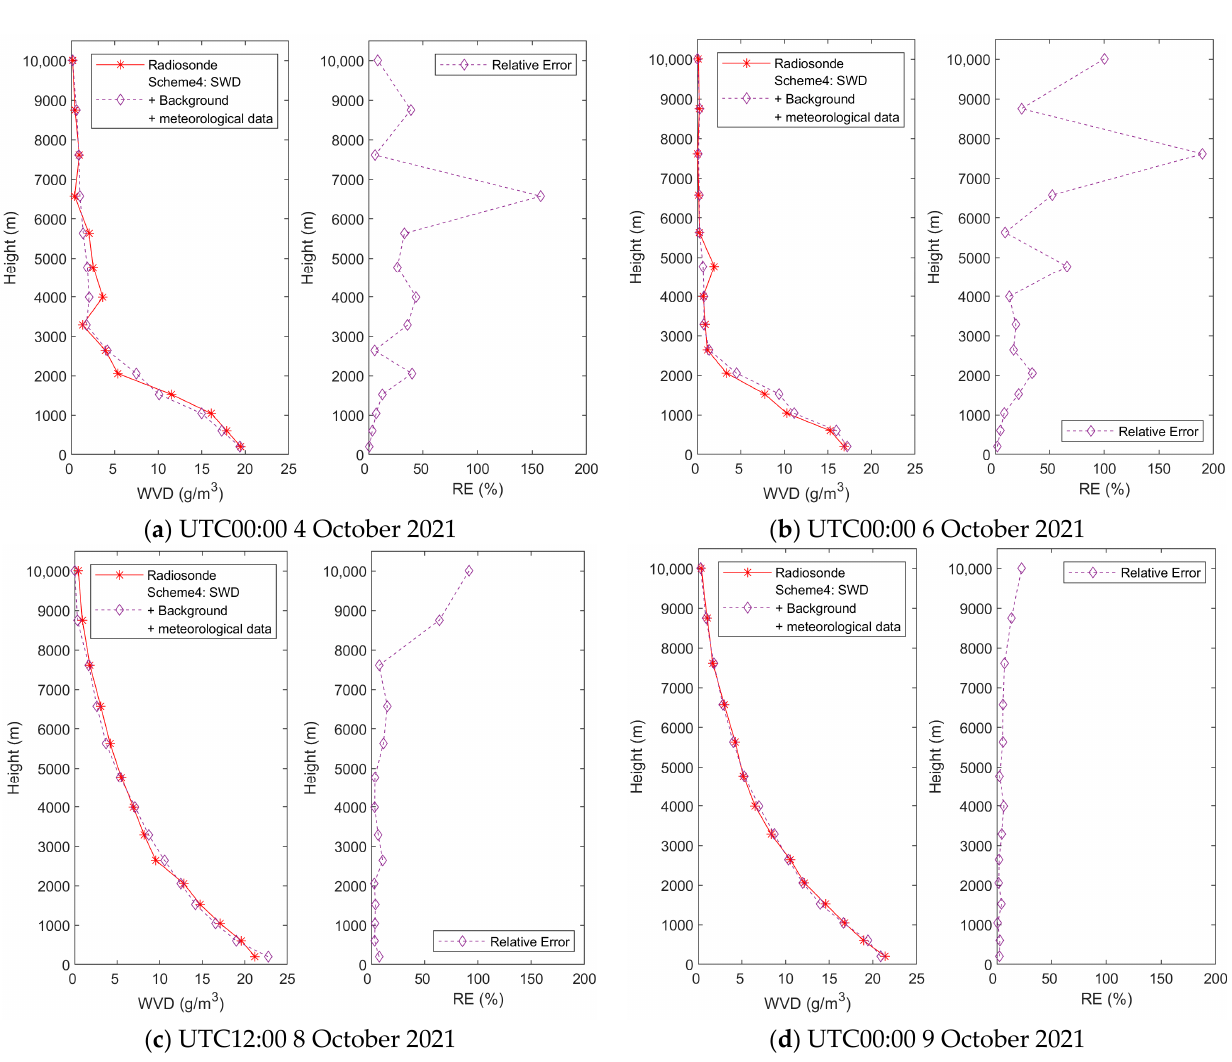
Figure 6. Vertical profiles of WVD and RE with respect to radiosonde results during non-rainy phases at two epochs ( a , b ) and rainy phases at other two epochs ( c , d ).